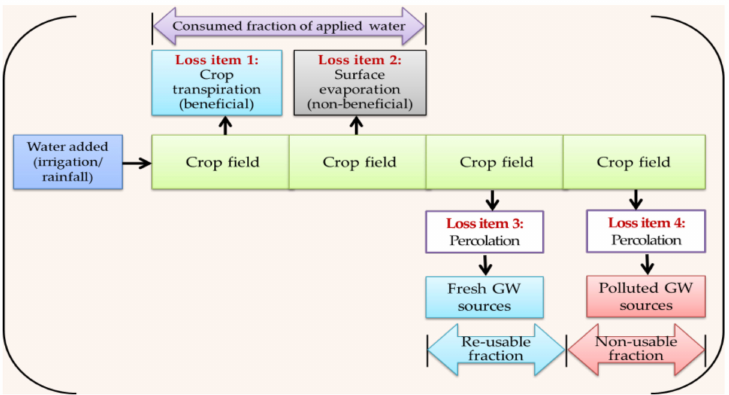
Figure 2. Utilization and fate of applied water to crop fields and hydrological links to groundwa- ter resources.